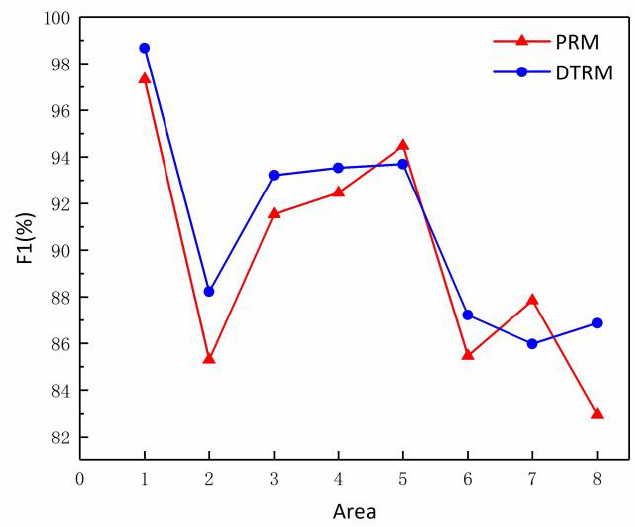
Figure 17. F1-score of DTRM and PRM in the eight areas (areas 1–8).